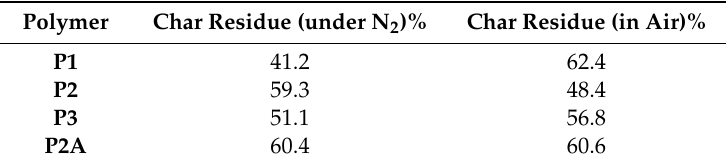
Table 2. Char residues (%) of the block copolymers P1 , P2 , P3 , and P2A (determined by thermal gravimetric analysis (TGA) under N 2 and in air) at 600 °C.